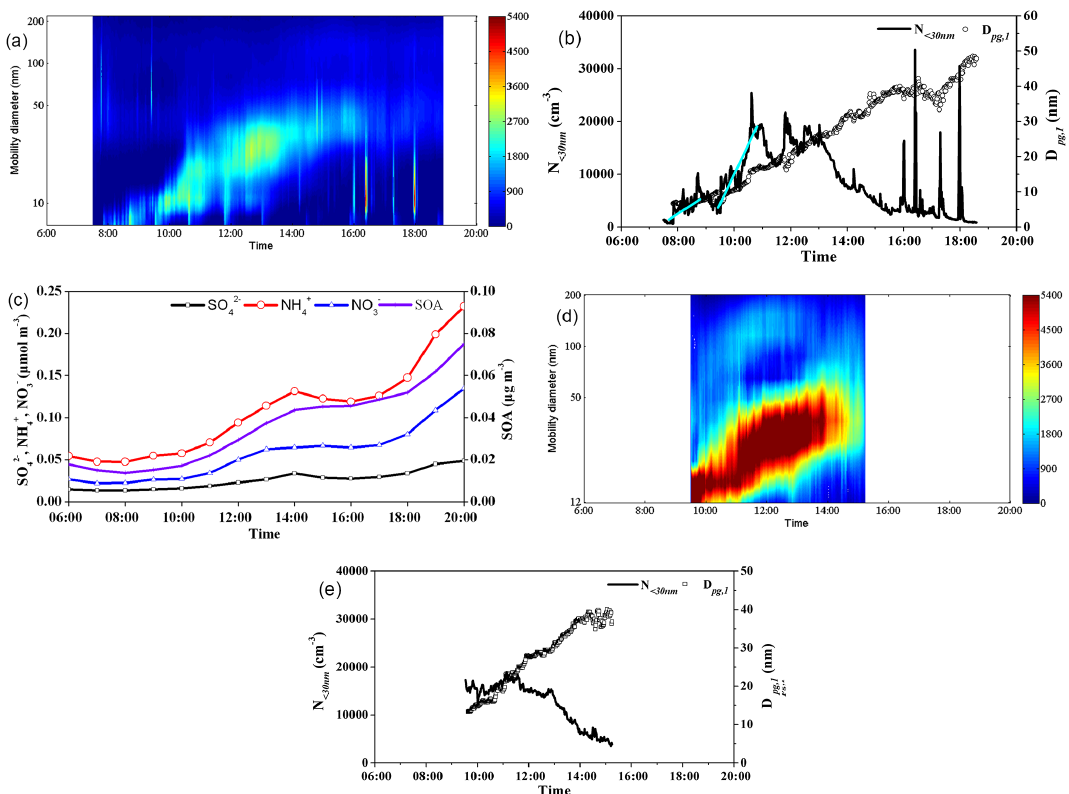
Figure 2. New particle formation events in marine (a–c) and coastal atmosphere on 4 November 2012 (d–e) , (a) particle number concen- trations from FMPS (cm − 3 ), (b, e) variations of median diameter of particle mode ( D pg , 1 ) and number concentrations of nucleation mode particles ( N < 30nm ) in marine and coastal atmosphere, (c) CMAQ simulation of SO 2 − (d) particle number concentrations from SMPS (cm − 3